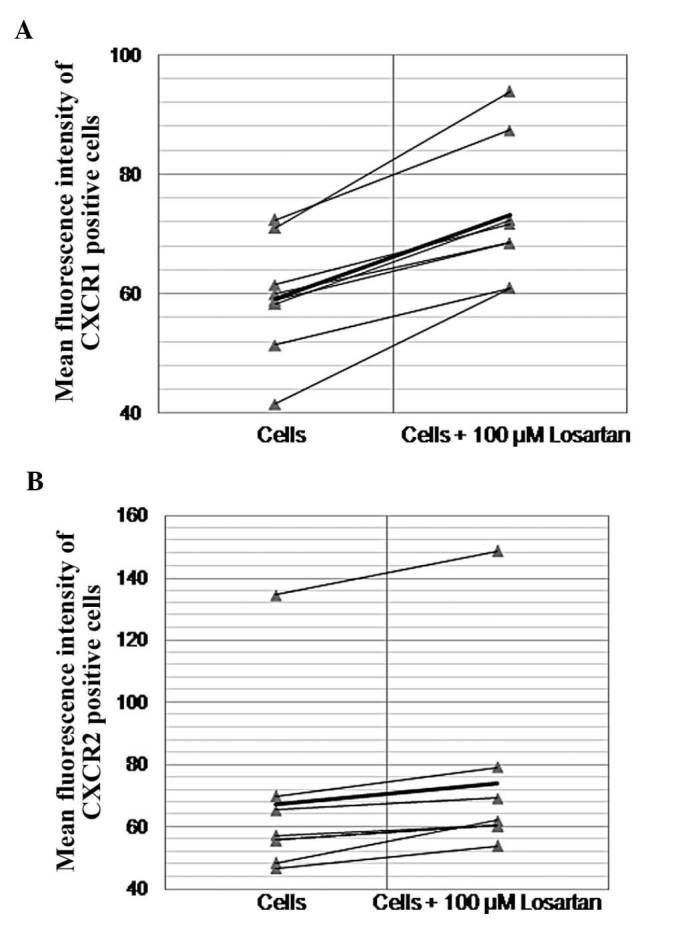
A graphic presentation of the impact of 100 μM of (A) losartan CXCR1 and (B) CXCR2 fluorescence intensity (Geo Mean) of THP-1 cells. Each thin line represents an individual experiment. The bold line is the mean effect.